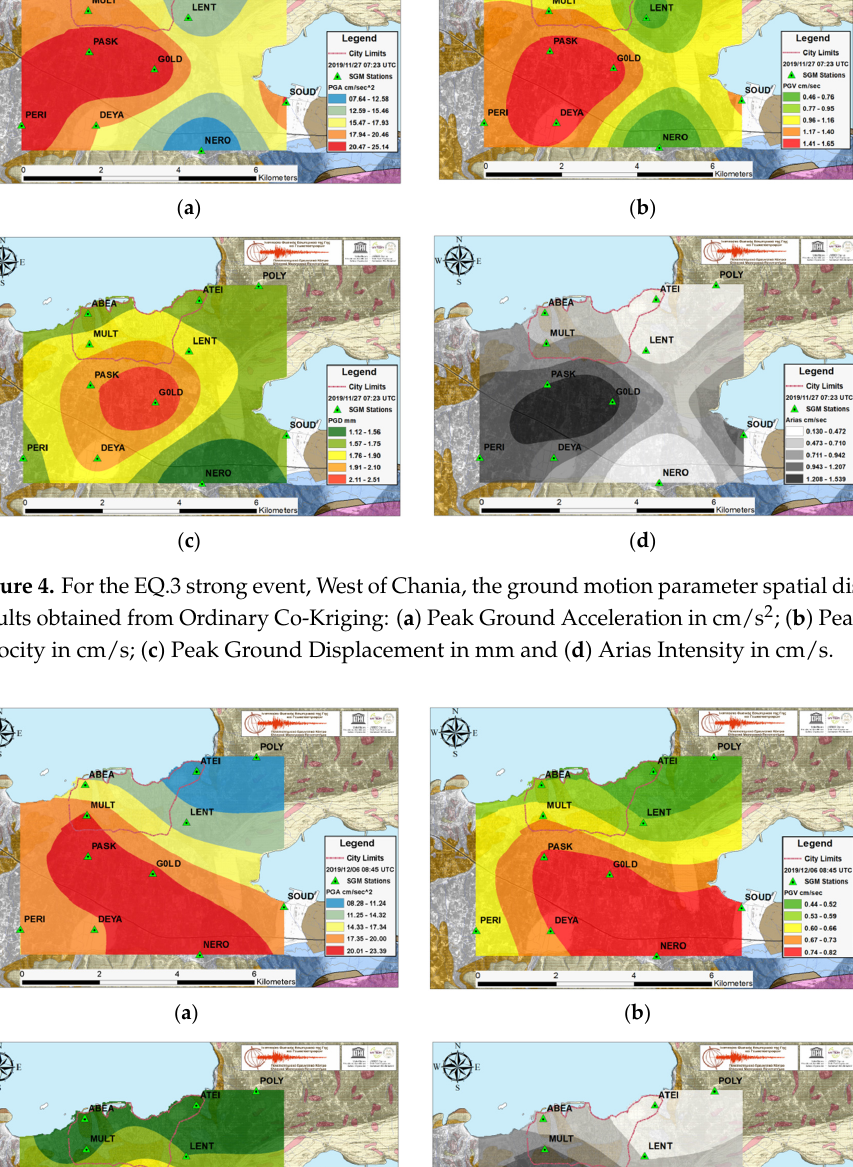
Figure 3. Comparative study of the spectral acceleration values for the same events recorded to selected SGMN stations located on different subsurface geology with contrast of seismic response: ( a ) G0LD-station on Quaternary deposits; ( b ) MULT-station on Neogene marles and Quaternary deposits; ( c ) SOUD-station on loose Quaternary deposits. Stations placed on Neogene limestones: ( d ) ATEI- station; ( e ) LENT-station and ( f ) POLY-station.